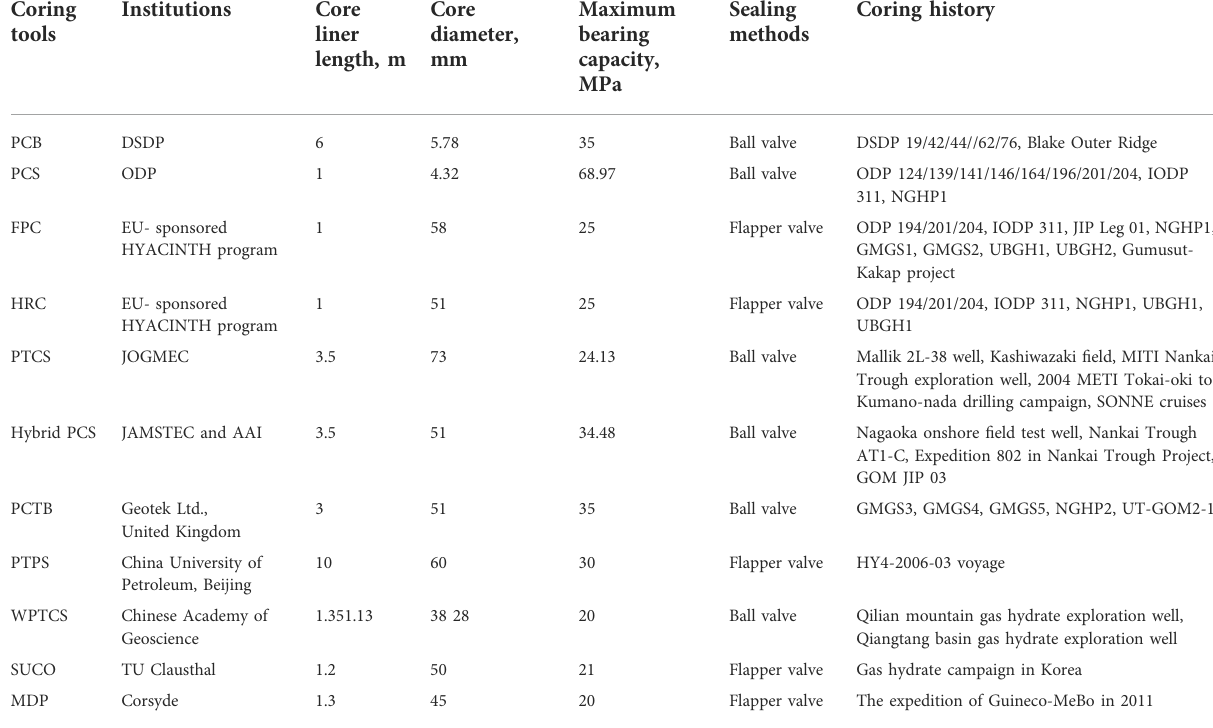
TABLE 7 Comparison of operation conditions of different pressure coring systems. Coring